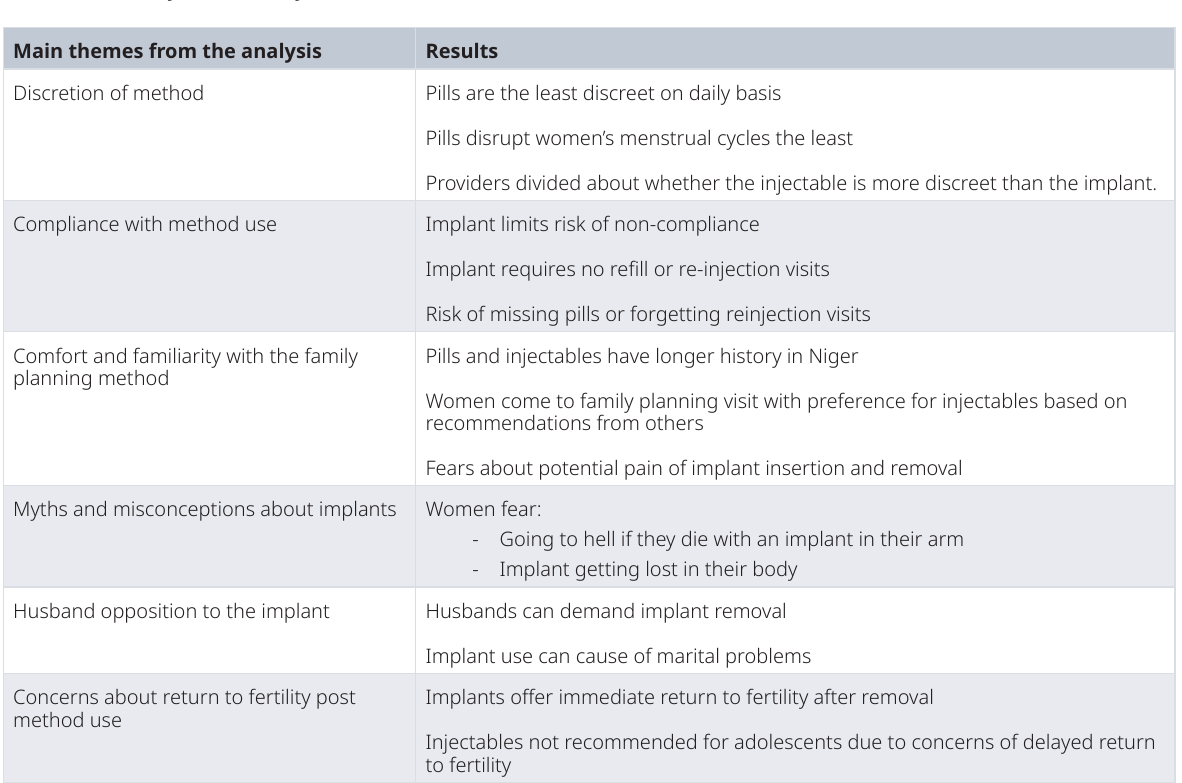
Table 2. Summary of results by main